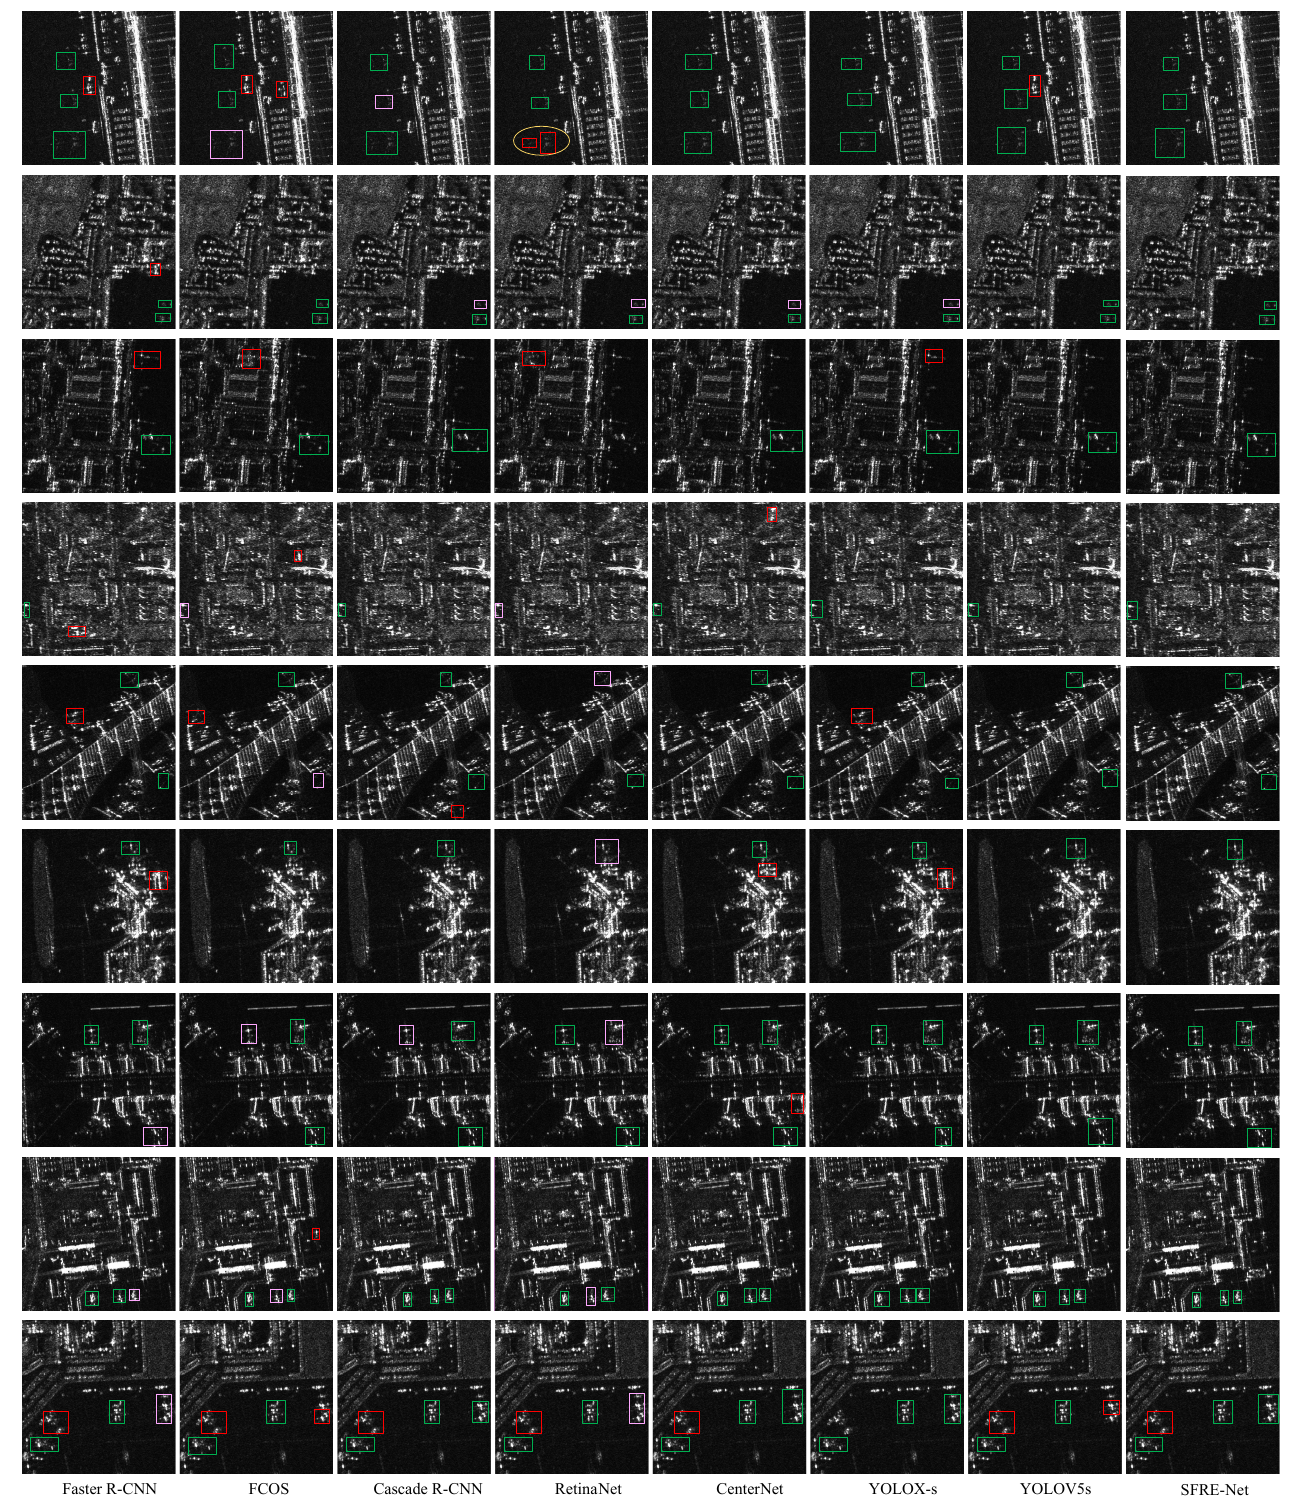
Figure 10. Detection results of different algorithms. The green boxes, pink boxes, red boxes, and yellow ellipses denote the correct predictions, missing objects, false alarms, and entire aircrafts,